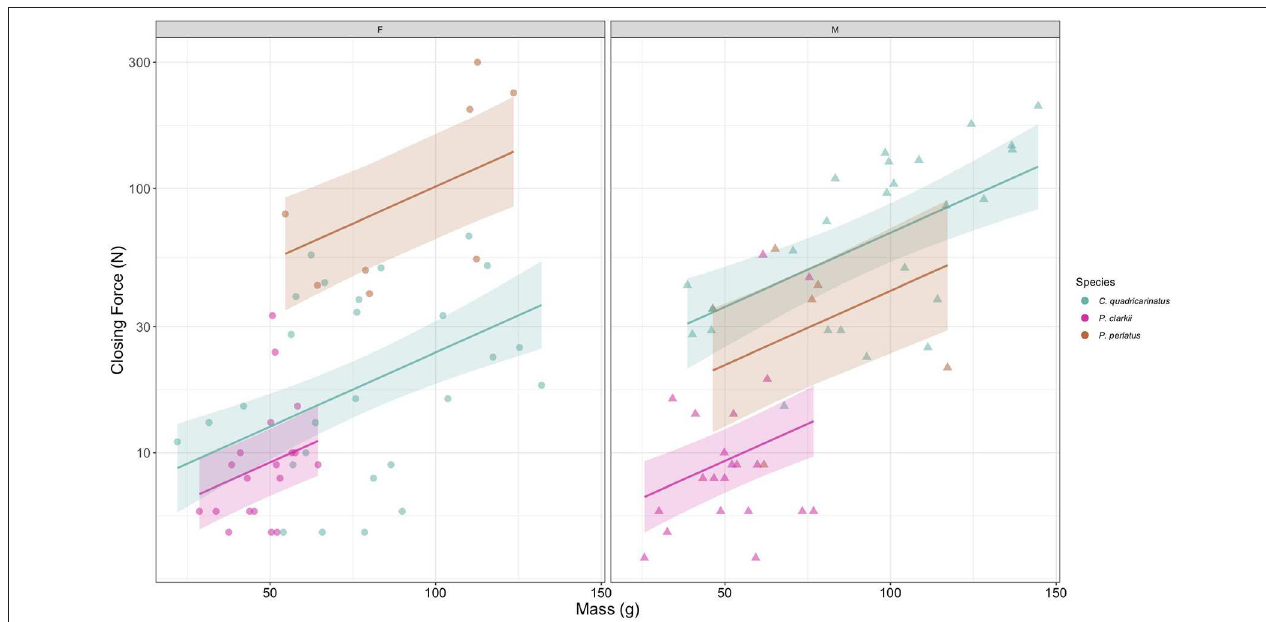
FIGURE 3 | Predicted maximum closing force correlation with mass (g) of female (left panel) and male (right panel) P. perlatus , C. quadricarinatus , and P. clarkii with 95% confidence intervals. Individual points indicate raw data points for each species.